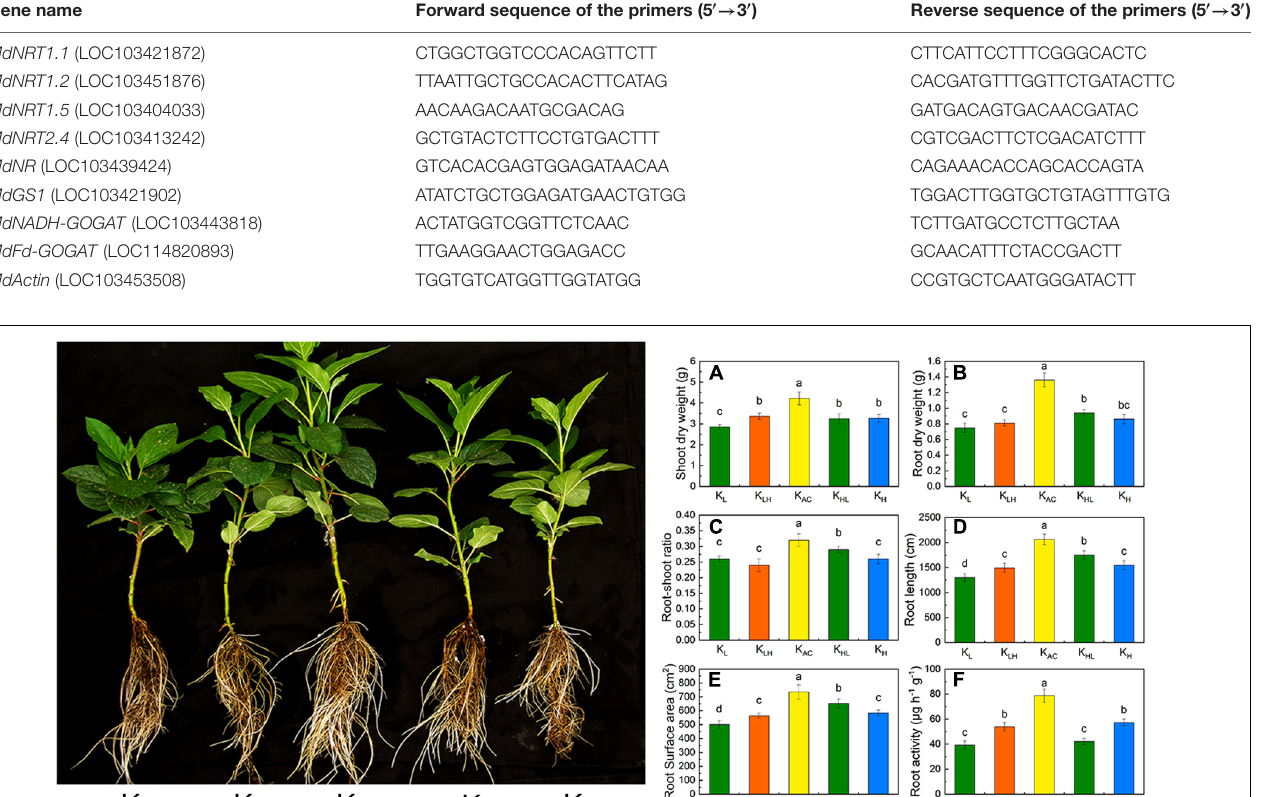
TABLE 1 | Primer sequences for RT-qPCR.